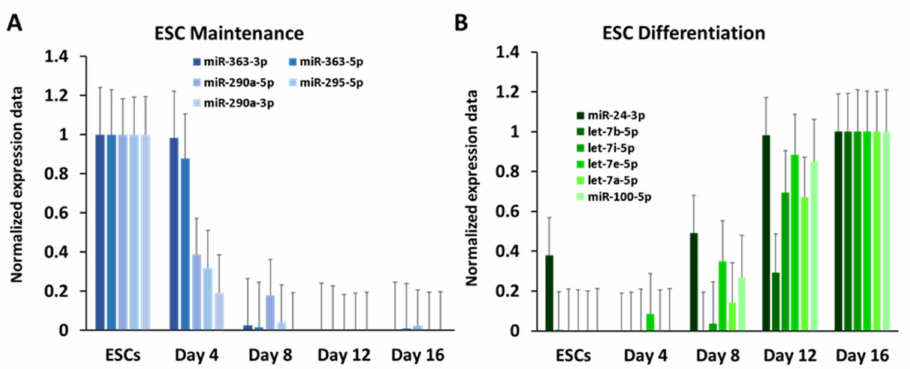
Figure 4. Expression of miRNAs markers. ( A ) Pluripotency miRNAs; ( B ) developmental miRNAs. Expression values for each gene were normalised to have a minimum value of 0 and a maximum value of 1. Standard error bars are